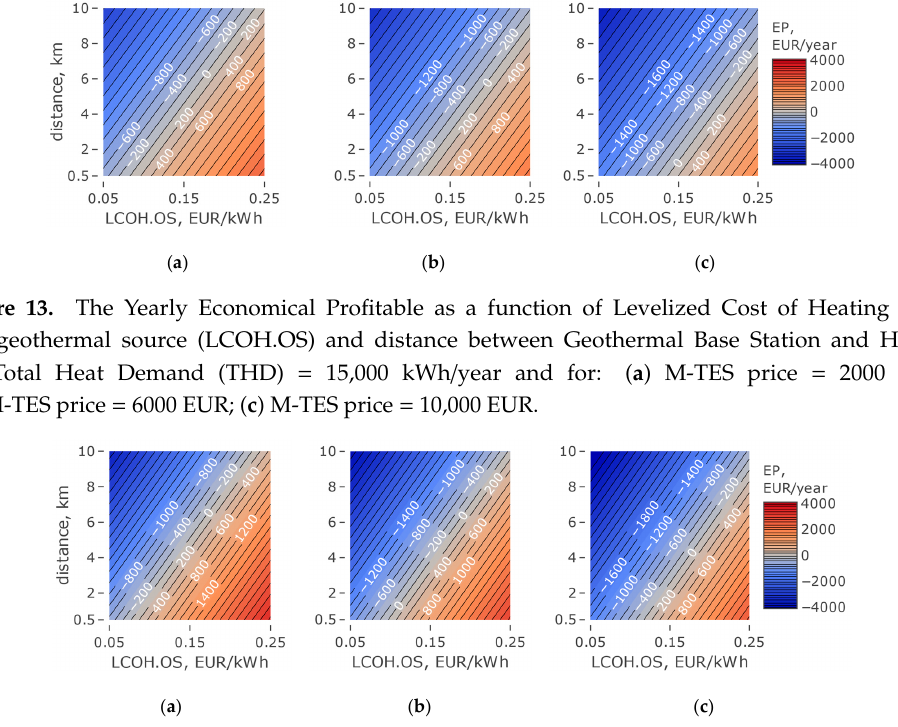
Figure 14. The Yearly Economical Profitable as a function of Levelized Cost of Heating from non-geothermal source (LCOH.OS) and distance between Geothermal Base Station and House, for Total Heat Demand (THD) = 20,000 kWh / year and for: ( a ) M-TES price = 2000 EUR; ( b ) M-TES price = 6000 EUR; ( c ) M-TES price = 10,000 EUR. Energies 2020 , 13 , x FOR PEER REVIEW